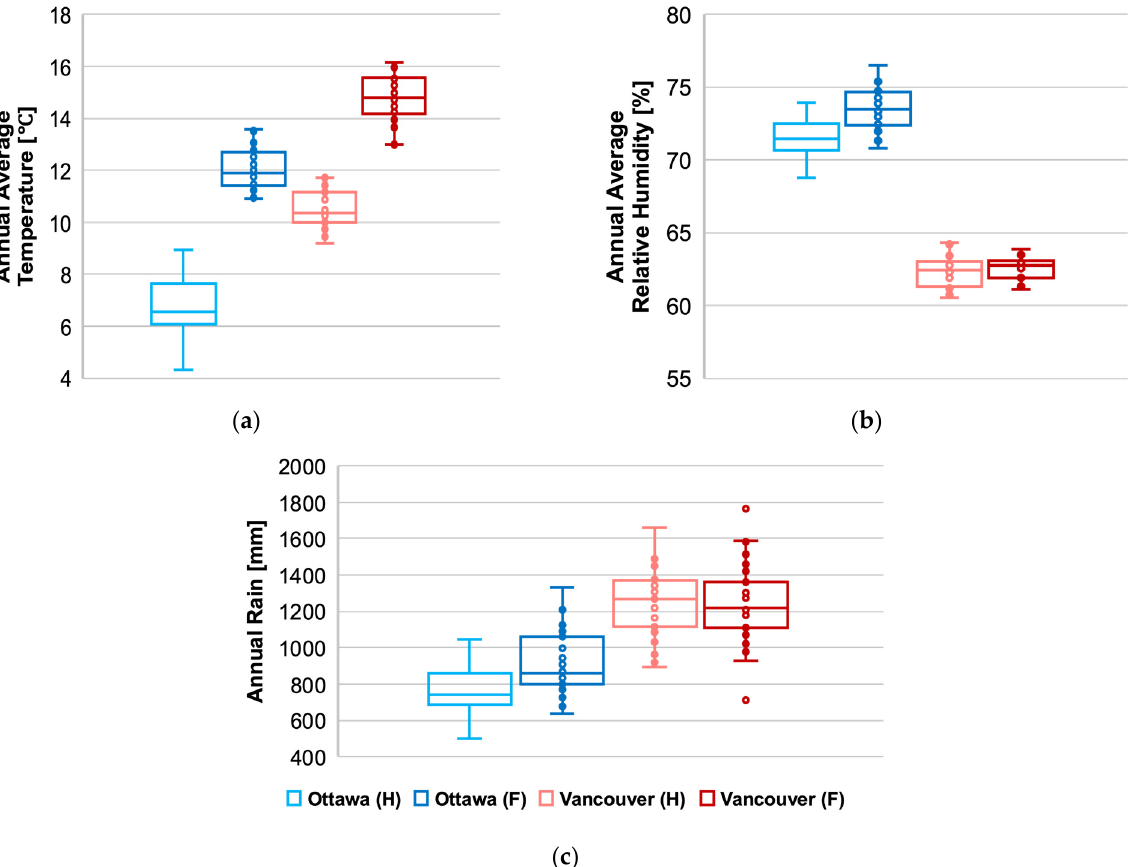
Figure 2. Comparison of ( a ) annual average temperature, ( b ) annual average relative humidity, and ( c ) annual rainfall, during the time periods of 1989–2016 (H) and 2062–2092 (F) in Ottawa and Vancouver.